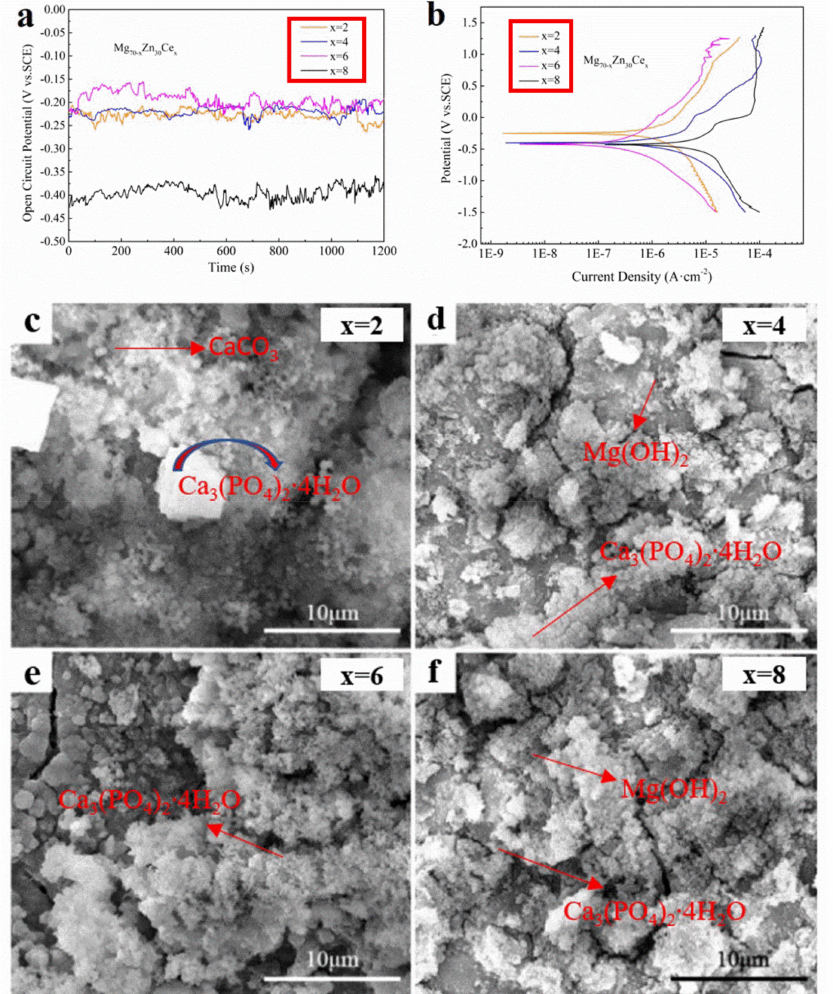
Figure 8. ( a ) OCP curves of Mg 70-x Zn 30 Ce x (x = 2, 4, 6 and 8), and ( b ) polarization curves of Mg 70 − x Zn 30 Ce x (x = 2, 4, 6 and 8). Surface morphologies of the Mg 70 − x Zn 30 Ce x (x = 2, 4, 6, and 8) amorphous alloy samples after immersion in SBF for three days: ( c ) Mg 68 Zn 30 Ce 2 , ( d ) Mg 66 Zn 30 Ce 4 , ( e ) Mg 64 Zn 30 Ce 6 , and ( f ) Mg 62 Zn 30 Ce 8